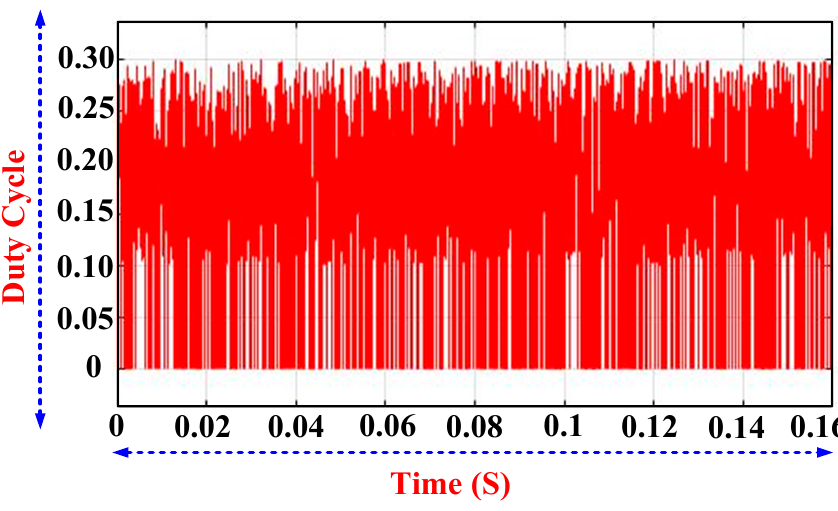
Figure 8. Varying duty cycle of Particle Swarm Optimization (PSO) algorithm.